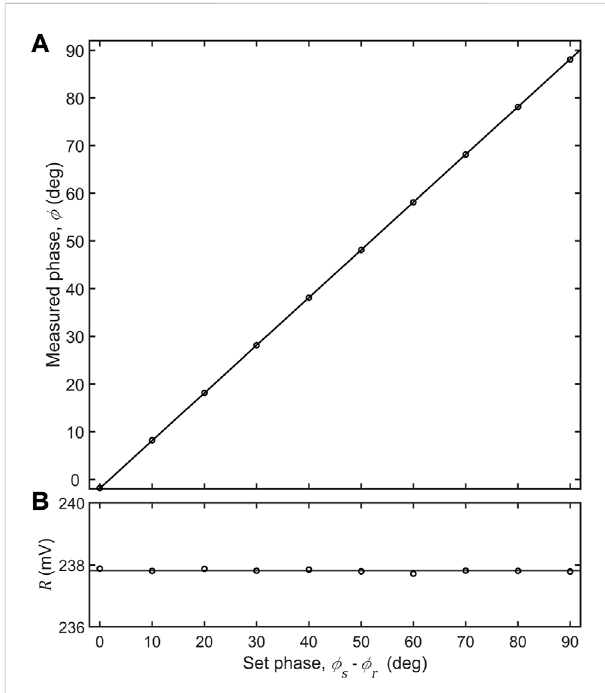
FIGURE 6 (A) Measured phase ϕ versus the relative phase ϕ s − ϕ r between the input and reference signal. The straight line shows a linear least- squares fi t with unity gradient and − 1.8680 ° vertical offset. (B) Measured amplitude R versus the relative phase ϕ s − ϕ r